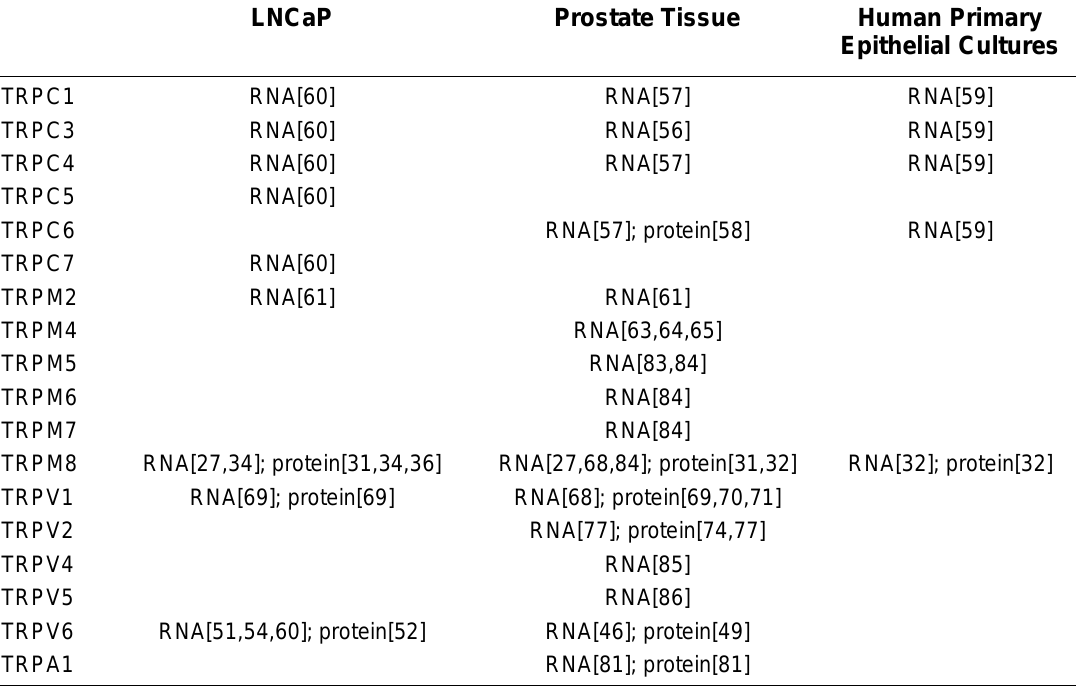
Overview of TRP Channel Expression in (Random) Human Prostate, LNCaP Cells, and